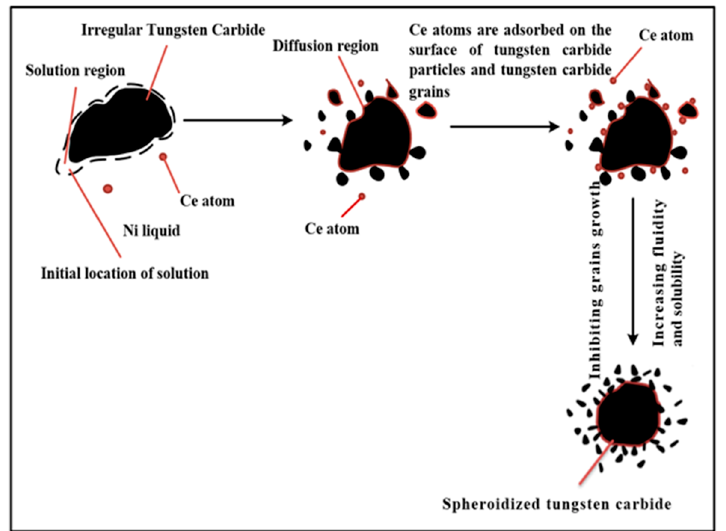
Figure 5. The mechanism model of the CeO 2 in Ni-based tungsten carbide cladding